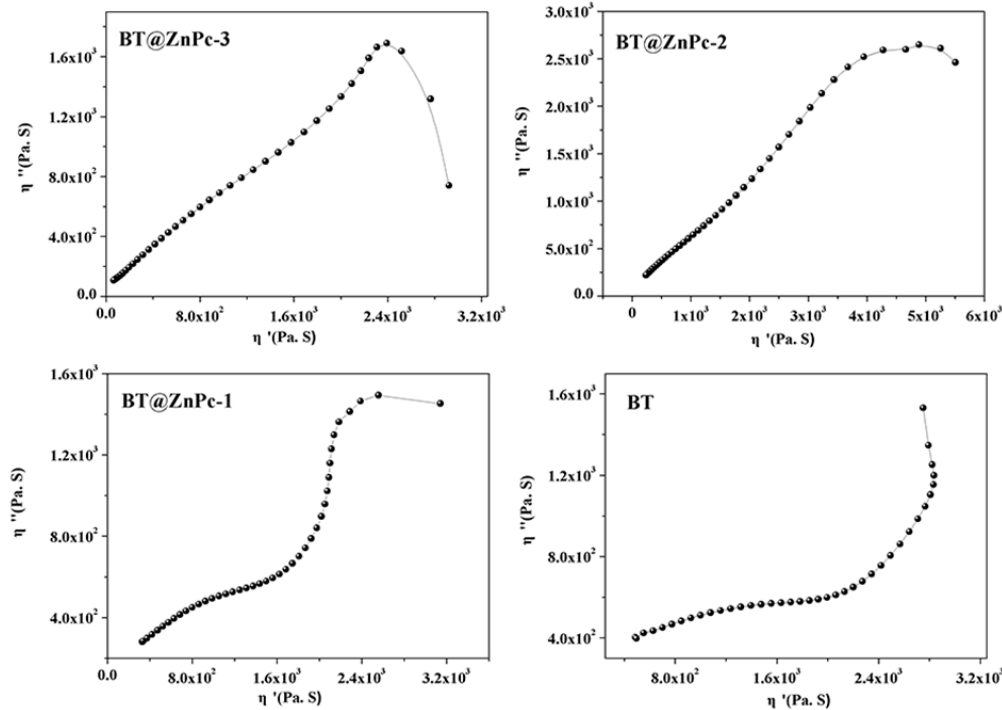
Figure 4. Cole-Cole plot curves of PEN composites with 30 wt% of BT@ZnPc-3; BT@ZnPc-2; BT@ZnPc-1 and